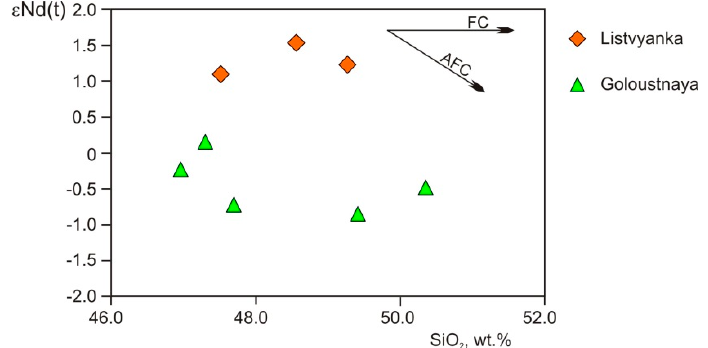
Figure 9. ɛ Nd(t)–SiO 2 diagram for Listvyanka and Goloustnaya dolerites. FC, fractional crystallization; AFC, assimilation and fractional